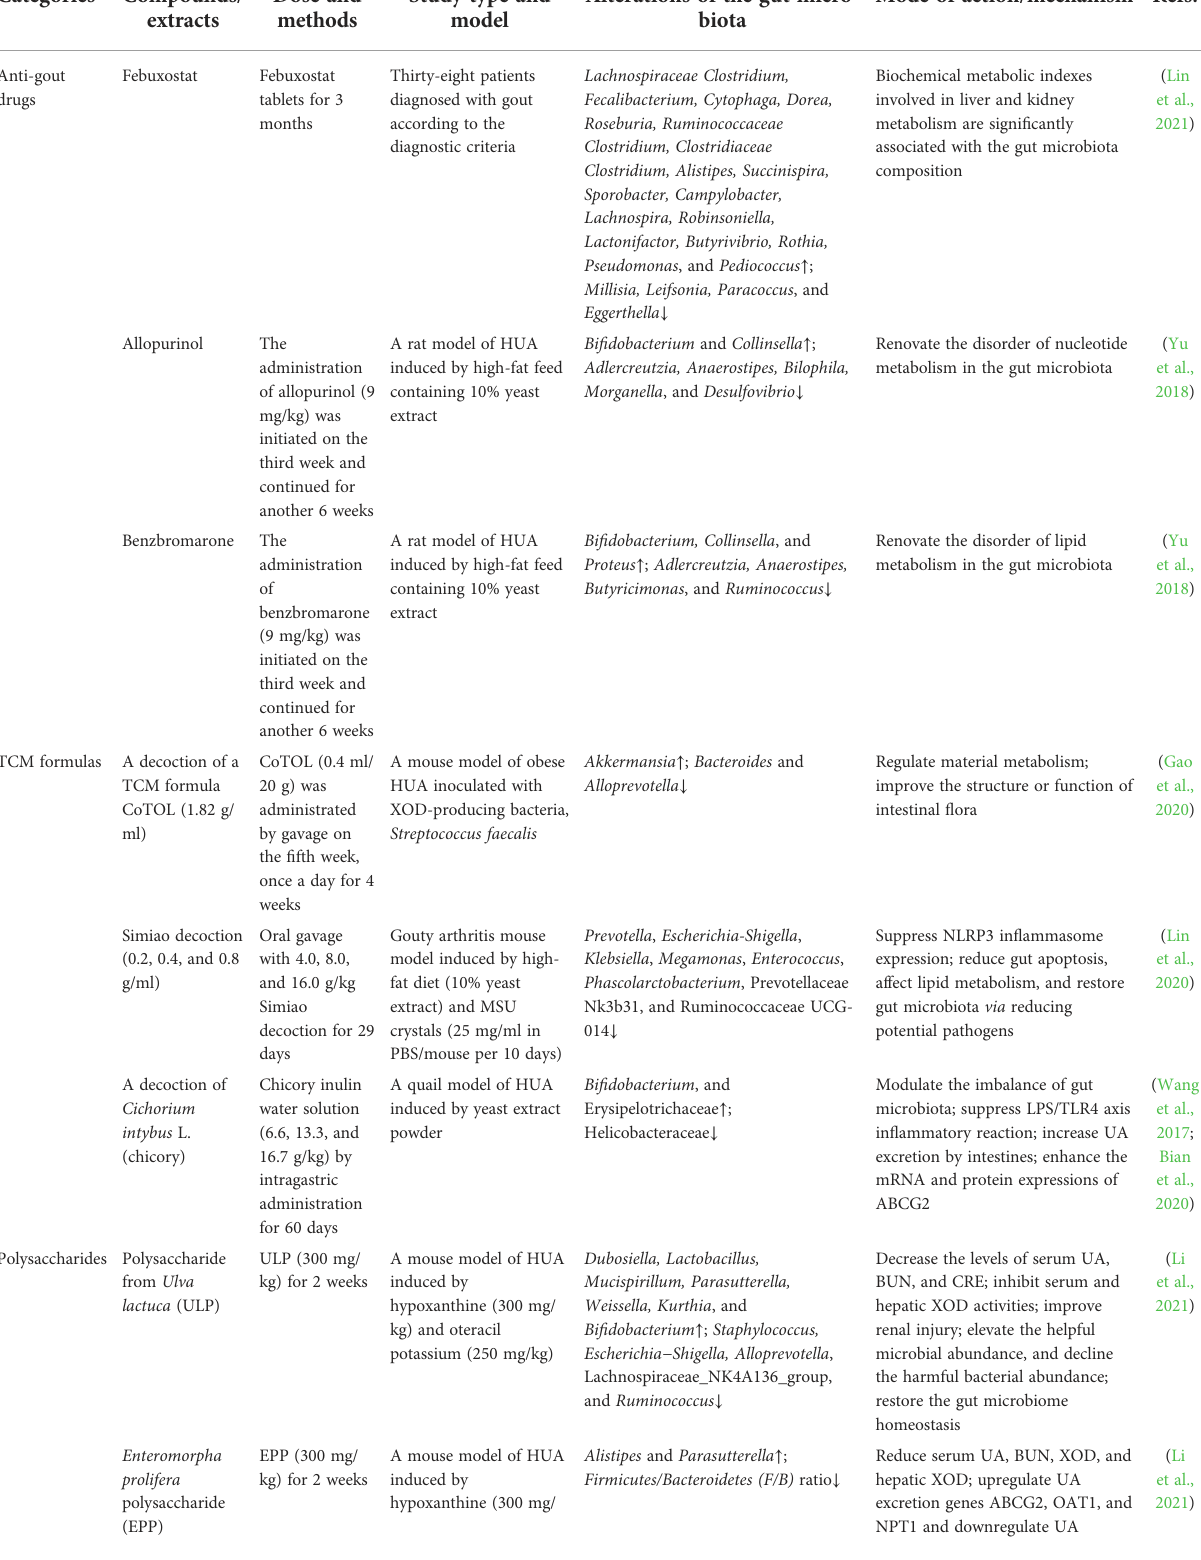
TABLE 2 Experiment and mechanism of prebiotics in prevention of HUA and gout targeting gut